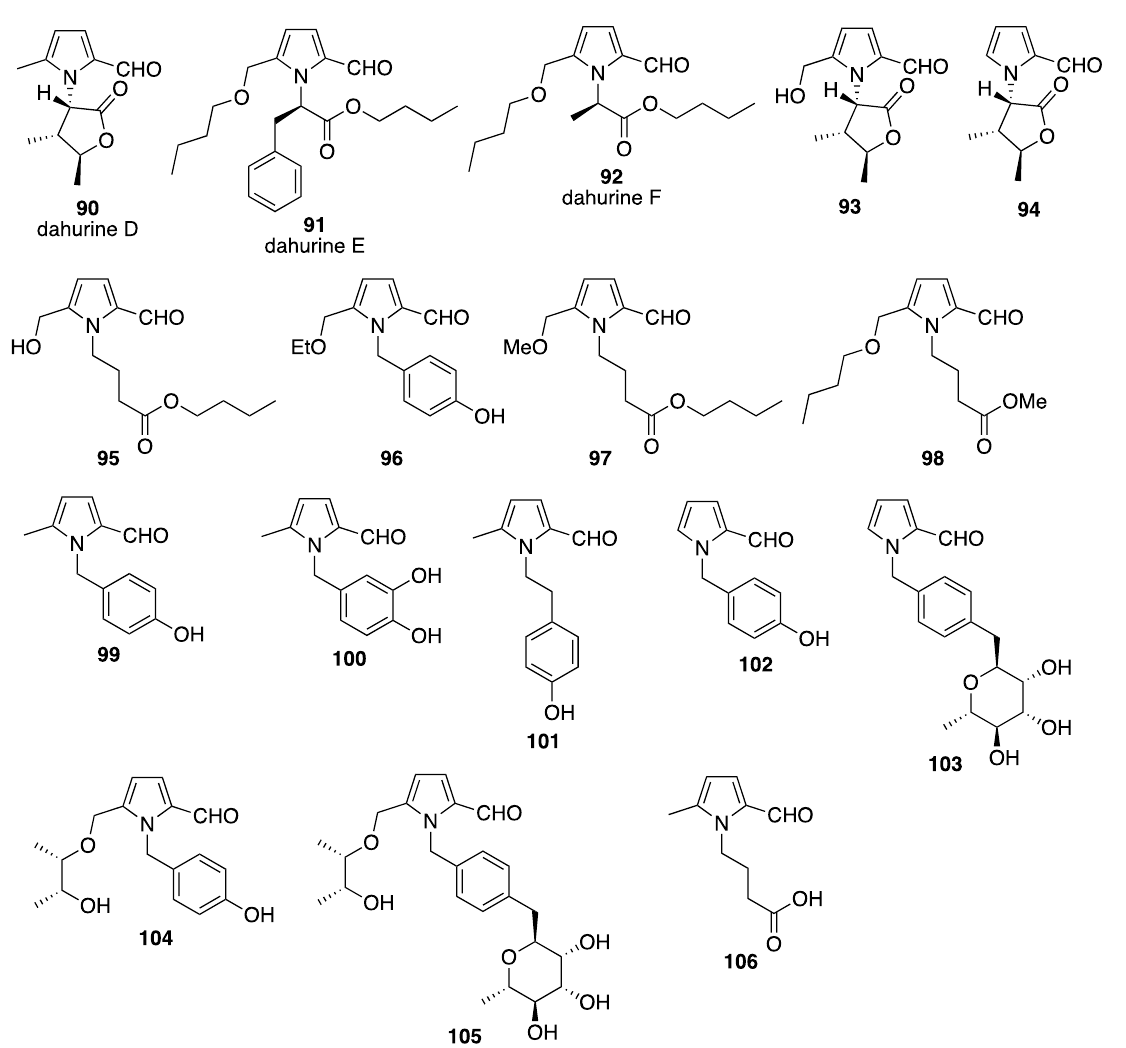
Figure 4. Structures of Py-2-Cs from plant sources.